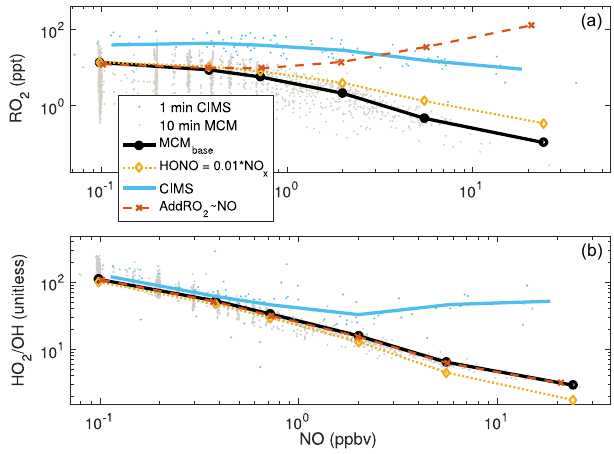
Figure 5. C-130 CIMS RO 2 (a) and HO 2 / OH ratio (b) and as a function of aircraft NO (chemiluminescence, 20pptv ± 10%, 1 σ uncertainty) and modeled RO 2 and HO 2 / OH ratio versus con- strained NO measured continuously in Golden, CO. Aircraft mea- surements used are limited to the first 1km in the boundary layer and only for times when the C-130 was within 20km of Golden, CO. A well-mixed boundary layer is assumed for all